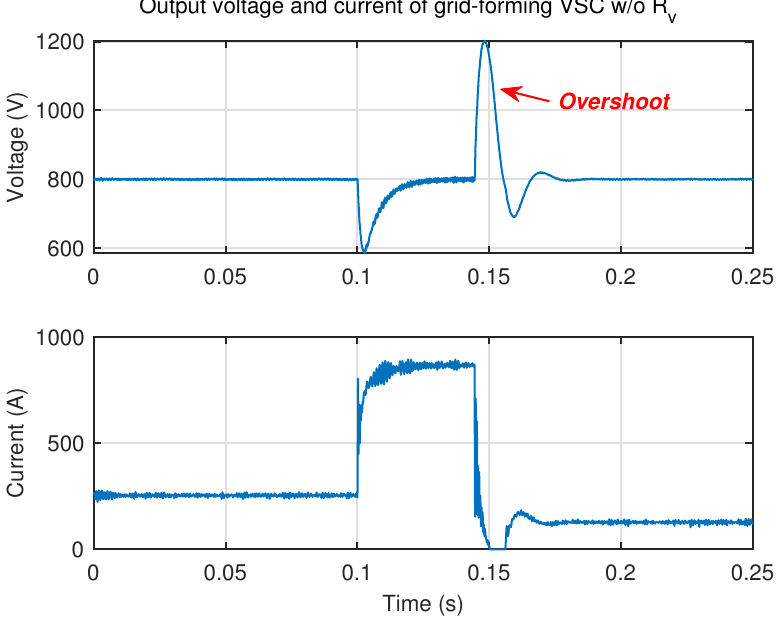
Figure 11. Output voltage and output current of grid-forming VSC without R v .